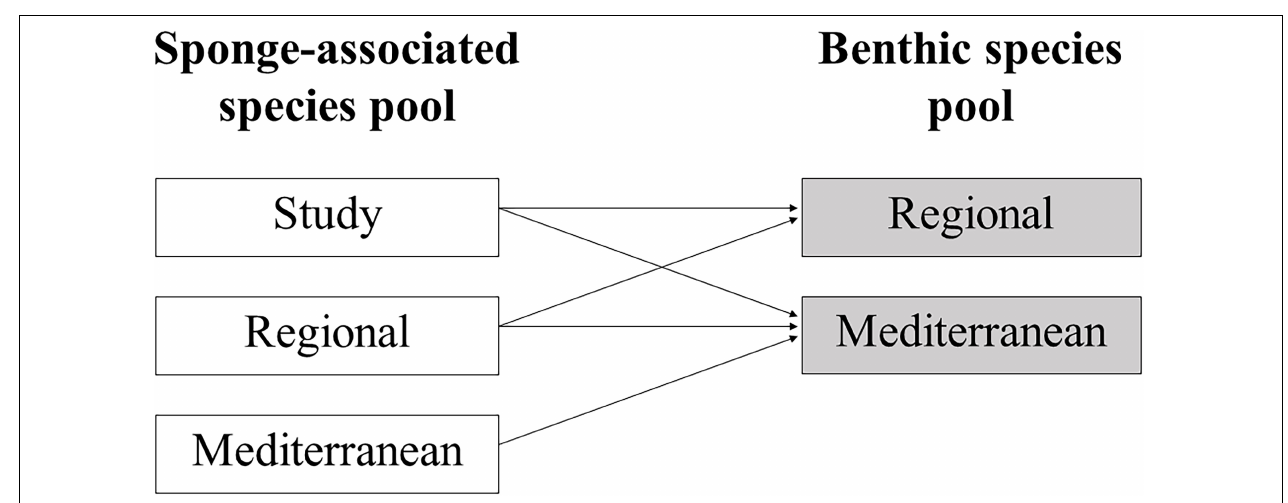
FIGURE 2 | Diagram representing the different levels of comparisons in the taxonomic relatedness